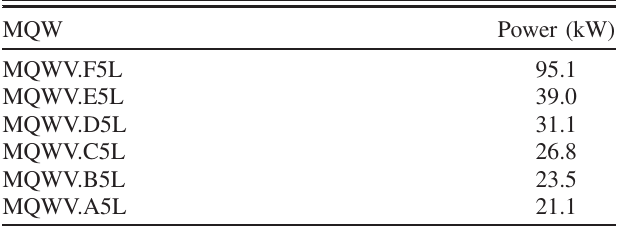
TABLE IV. Total power taken by the warm quadrupoles in cell 5, on the left side of IP7, for 0.2 h BLT.